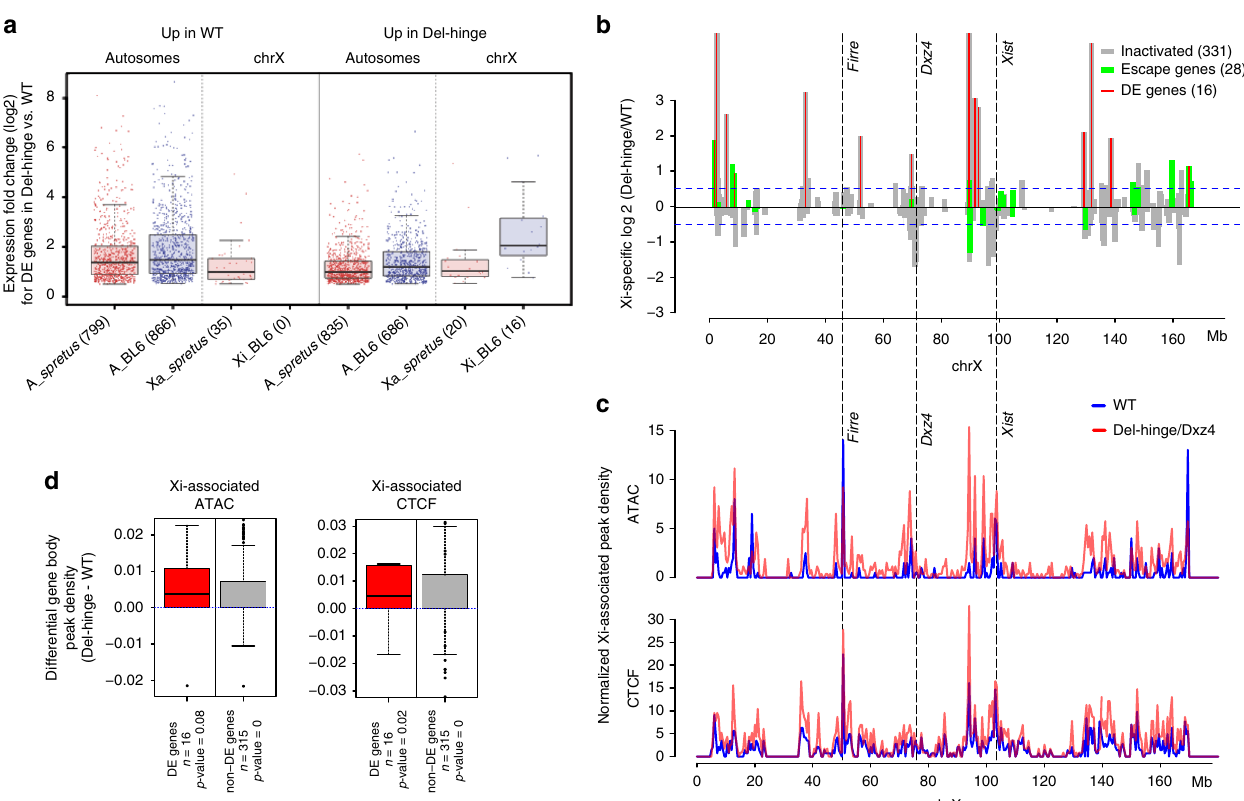
Fig. 9 Gene expression analyses. a Box plots showing the distribution of fold changes in allelic gene expression in Del-hinge versus WT for autosomal (A_ spretus or A_BL6) and X-linked (Xa or Xi) genes that have signi fi cantly increased expression (log2 > 0.5 and adjusted p -value < 0.05 by the Wald test) in WT or in Del-hinge as determine by DESeq2 59 . Red, spretus alleles; blue, BL6 alleles. Box and whisker demarcations as described for Fig. 8c – f. b Distribution of genes with expression fold changes between Del-hinge versus WT along the length of the Xi, considering 331 genes normally subject to XCI (gray) and 28 genes that escape XCI (green) (note only 28/29 escape genes could be tested for differential expression because Slc16a2 lacked the allelic coverage to do so). The 16 genes that show signi fi cant differential expression are demarcated with red vertical lines. The positions of Firre , Dxz4 , and Xist are indicated. c Plots of Xi-associated (common + Xi-speci fi c) ATAC and CTCF peak density (counts binned within 500 kb windows) along the X chromosome for WT (blue) and Del-hinge (red) aligned with expression fold changes in a . To account for differences in the number of SNP-covered peaks obtained between samples due to differences in the depth of sequencing (Supplementary Tables 3 and 5), the binned counts are scaled by a factor obtained from the between-sample ratios of autosomal diploid SNP-covered peaks. For CTCF the scaling factors are 0.7 and 0.87, while for the ATAC peaks the scaling factors are 0.5 and 0.38, for WT and Del-hinge, respectively. The positions of Firre , Dxz4 , and Xist are indicated. See also Supplementary Fig. 7c, d and 10c. d Box plots of differential Xi-associated ATAC and CTCF peak densities between Del-hinge and WT. Peak densities within X-linked gene promoter regions and gene bodies (10 kb upstream to TTS) are normalized for gene length and scaled by total diploid autosomal peak ratios. Genes are partitioned into those that show signi fi cant differential expression between WT and Del-hinge (DE; red) and those that did not (non-DE; gray). The number of genes in each group and the p -values from one-sided paired Wilcoxon tests are indicated. Box and whisker demarcations as described in 11e; Supplementary Data 5). Pair-wise comparisons between cell (Supplementary Fig. 12b, d; Supplementary Table 7; Supplemen- lines con fi rm limited expression changes between Inv-Dxz4 and tary Data 6 and 7). Patski2-4 (Supplementary Table 7).